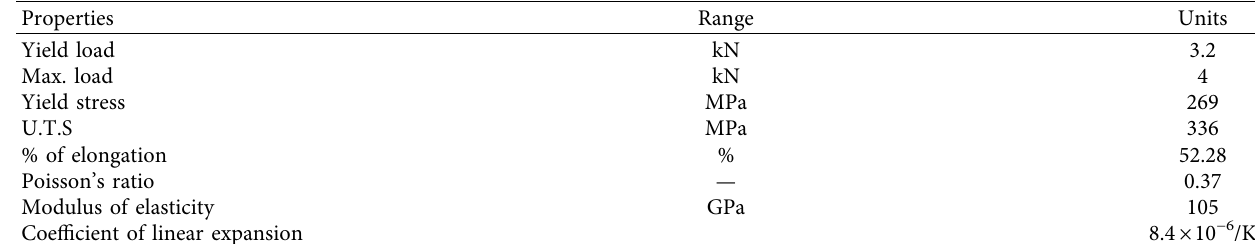
Figure 2: Schematic representation of ball-punch (Erichsen cupping) test methodology. Table 3: Physical and mechanical properties of CP-Ti material.